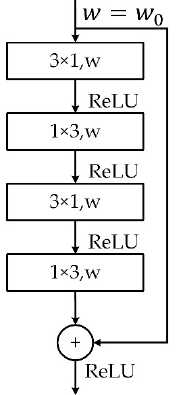
Figure 4. Non-bottleneck 1D structure.